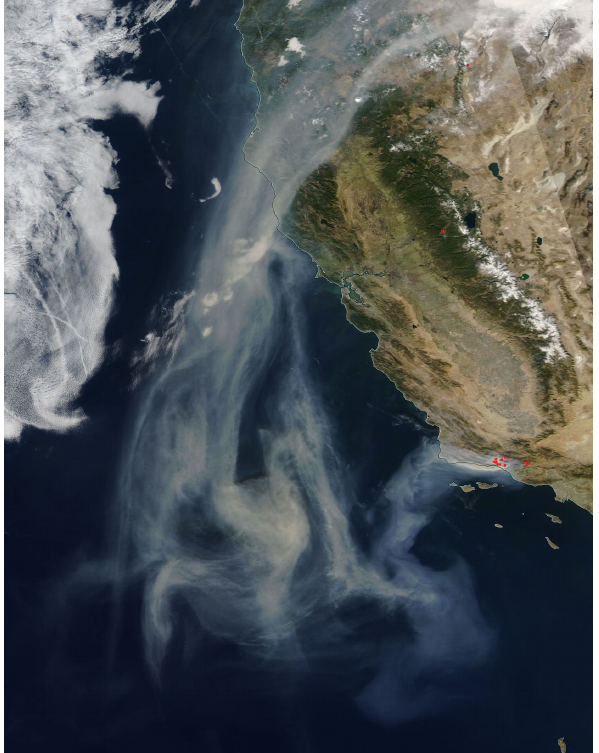
Figure A1. Smoke plume captured by Aqua MODIS for the Califor- nian fire event on 12 December 2017 (source: https://gibs.earthdata. nasa.gov, last access: 27 September 2018). The red regions indicate fires and thermal anomalies.